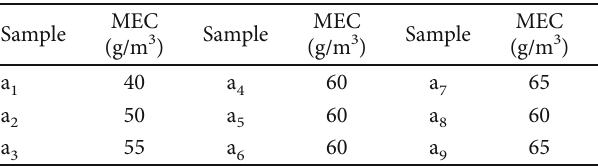
Figure 5: Maximum explosion pressures of the aluminum powders with di ff erent moisture contents. Table 4: Minimum explosible concentrations of aluminum powders with di ff erent moisture